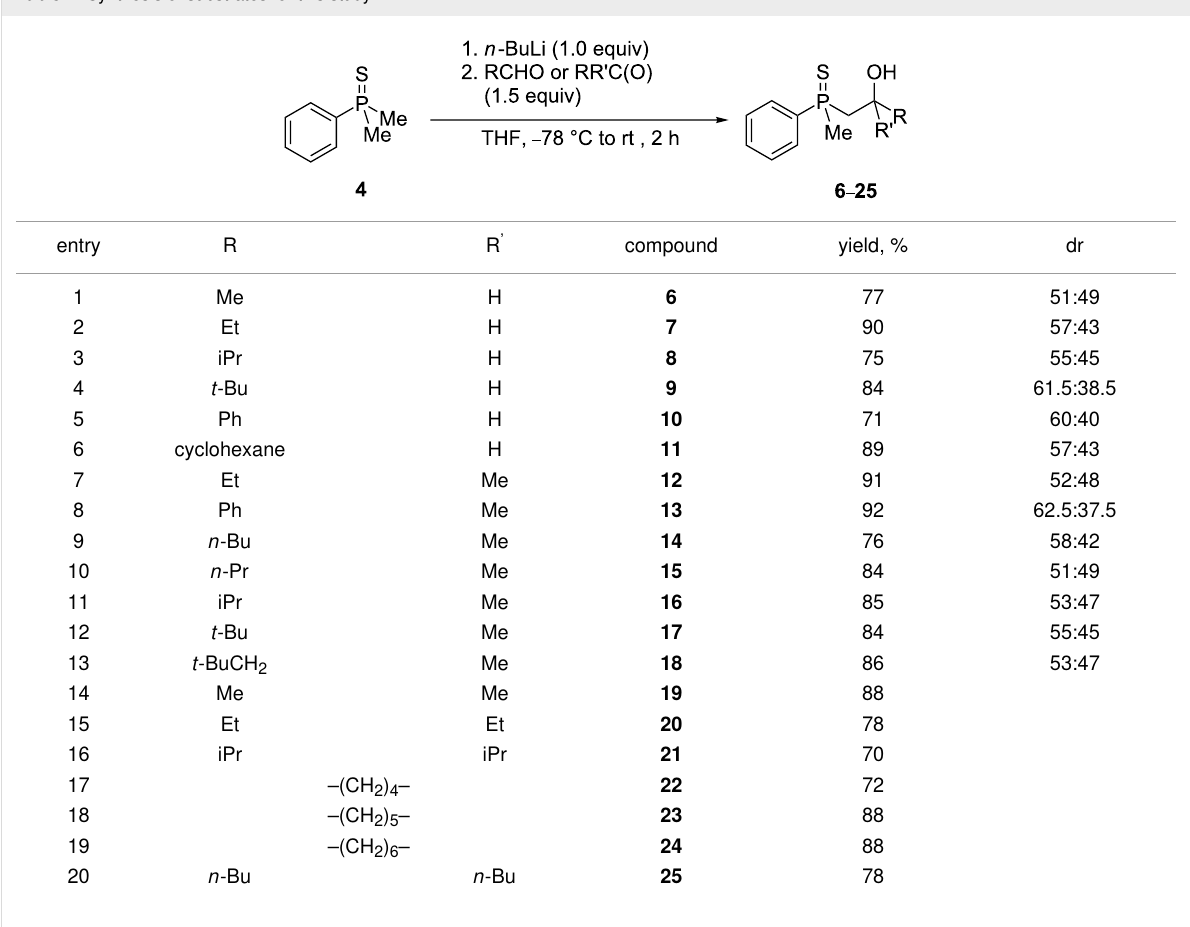
All compounds were obtained in good yields, both from alde- hydes and ketones. For aldehydes and unsymmetrically substi- tuted ketones, the formation of the products as diastereomeric mixtures could be observed. Unfortunately, the